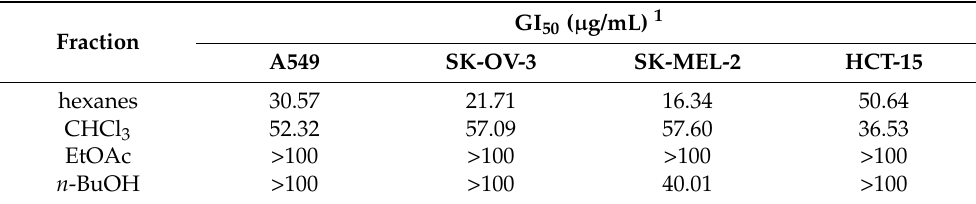
Table 1. Antiproliferative activities of hexanes-, CHCl 3 -, EtOAc-, and n -BuOH-soluble fractions of W. japonica MeOH extract against four cultured human cancer cell lines in the Sulforhodamine B (SRB)